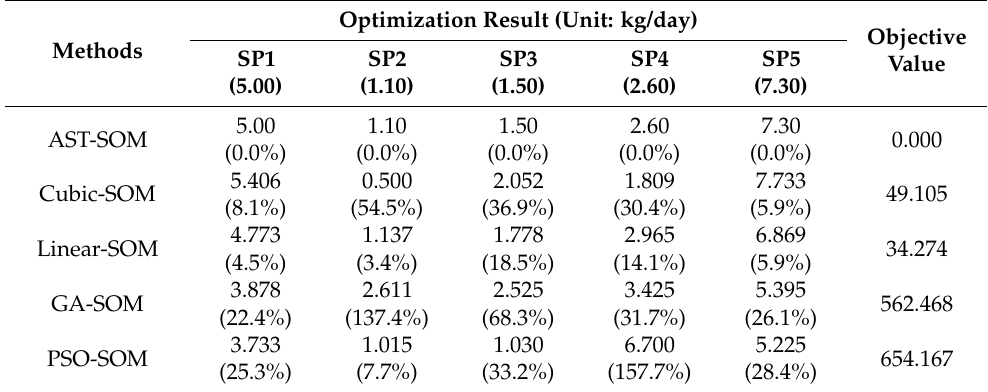
Table 6. The specific solutions of all used methods corresponding to the median value of Table